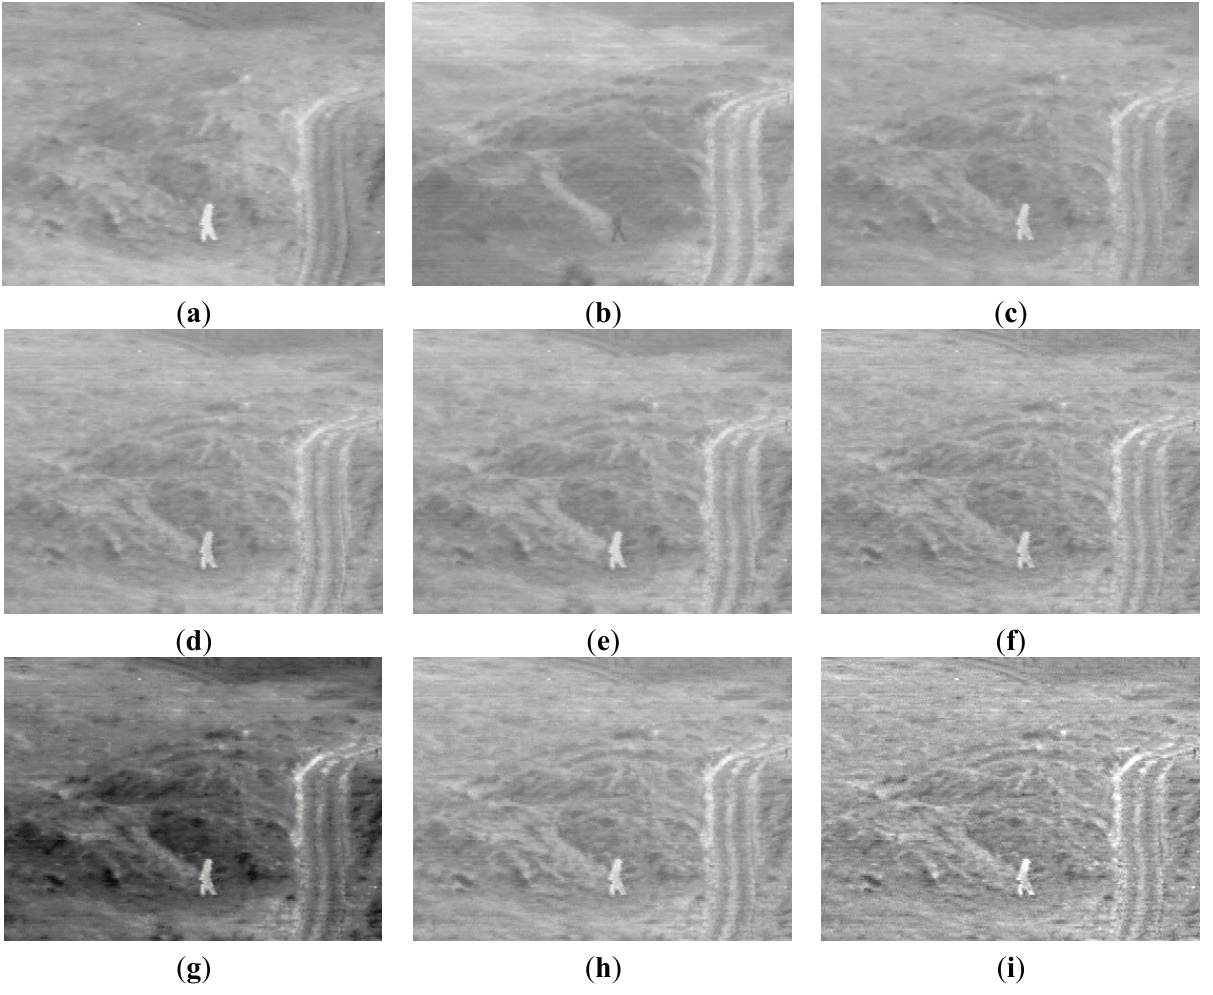
Figure 2. An example on Dune images. ( a ) Original infrared image ( b ) Original visual image ( c ) Result of MSTHT; ( d ) Result of SIDWT ( e ) Result of LP ( f ) Result of MSTHST; ( g ) Result of MSNTHT ( h ) Result of MSTOOC ( i ) Result of the proposed